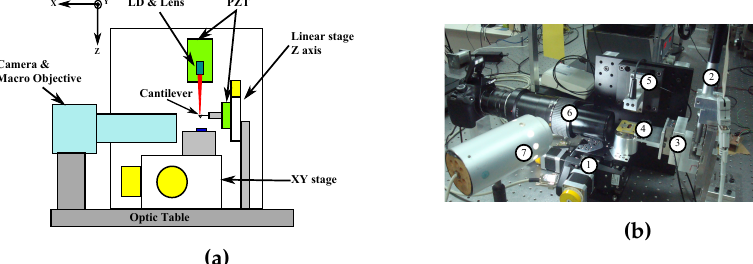
Figure 3. ( a ) Schematic of the mechanically-modulated OFI AFM setup; ( b ) Photograph of the implemented experimental setup: (1) XY translation stage; (2) Z-axis translation stage; (3) piezoelectric vibration displacement stage; (4) cantilever holder; (5) mechanically-modulated OFI sensor; (6) camera with macro objective; (7) white light source for